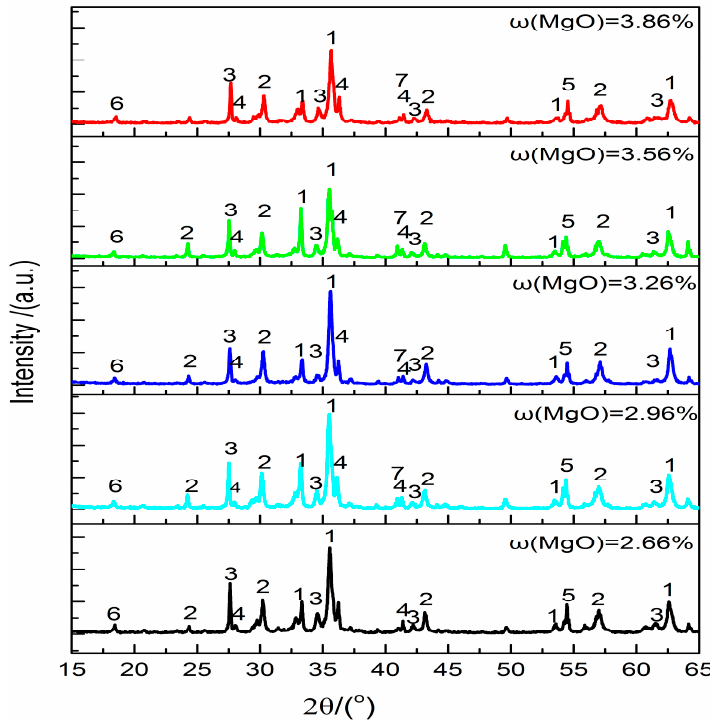
Figure 5. XRD pattern of the CCVTM sinter with various MgO concentrations: 1—Magnetite; 2—Hematite; 3—Calcium ferrite; 4—Perovskite; 5—Silicate; 6—Ilmenite; 7—Magnesium ferrite.